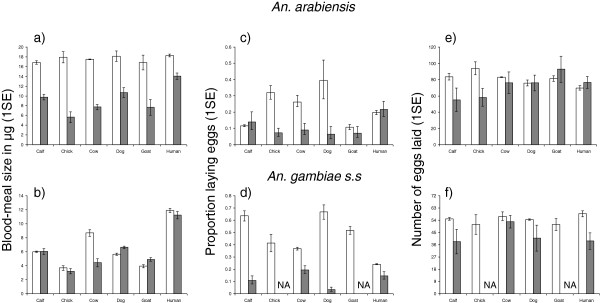
Mean blood meal size, oviposition rate, and number of eggs produced by An. arabiensis, and An. gambiae s.s after blood feeding on different host types either under semi-field conditions where hosts were free to move (open box), or when applied directly to the skin surface of immobile hosts (grey box). Error bars represents 1 standard error.